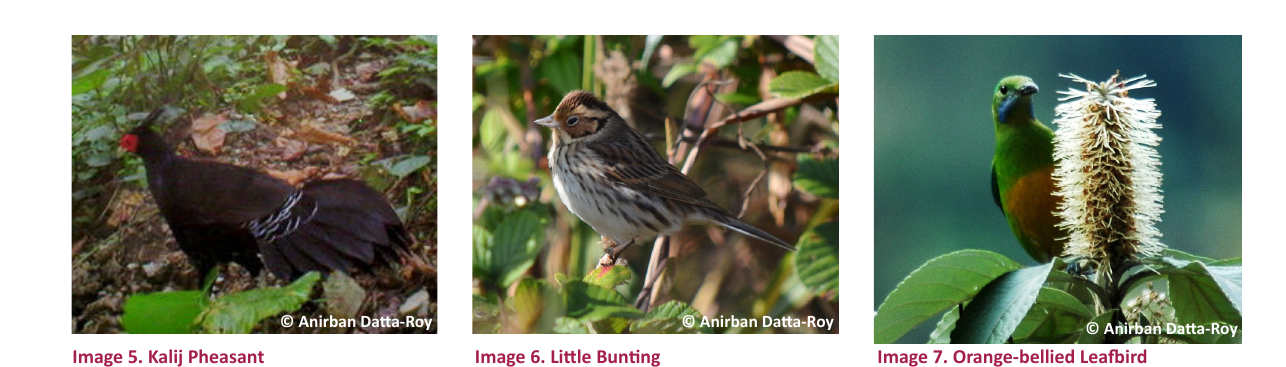
Image 5. Kalij Pheasant Image 6. Little Bunting Image 7. Orange-bellied Leafbird